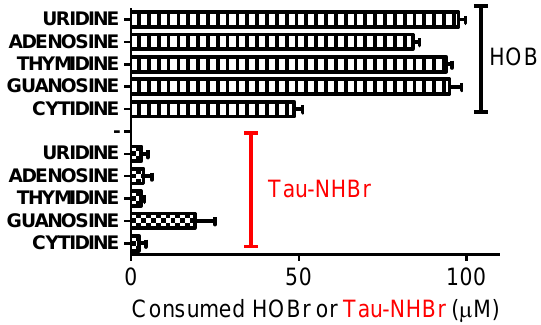
Figure 12. Reactivity of Tau-NHBr and HOBr with nucleosides. The reaction mixtures were composed of 100 µM Tau-NHBr or HOBr and 100 µM nucleosides in 50 mM phosphate buffer, pH 7.0. After 30 min the remaining oxidants were measured by the TNB method. The results are the mean of three experiments.